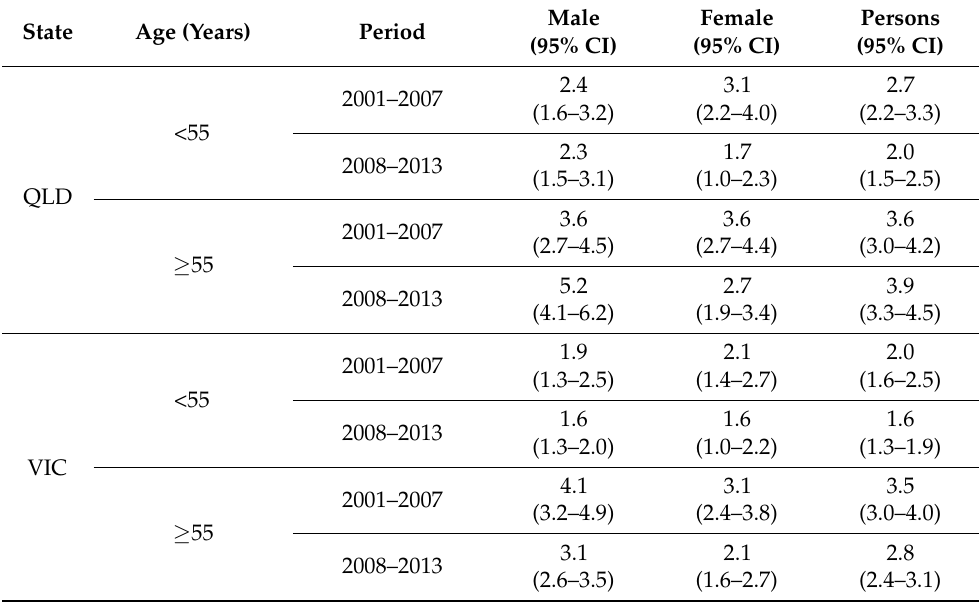
Table 4. UM ASR 1 in QLD and VIC in different ages in 2001–2007 and 2008–2013.